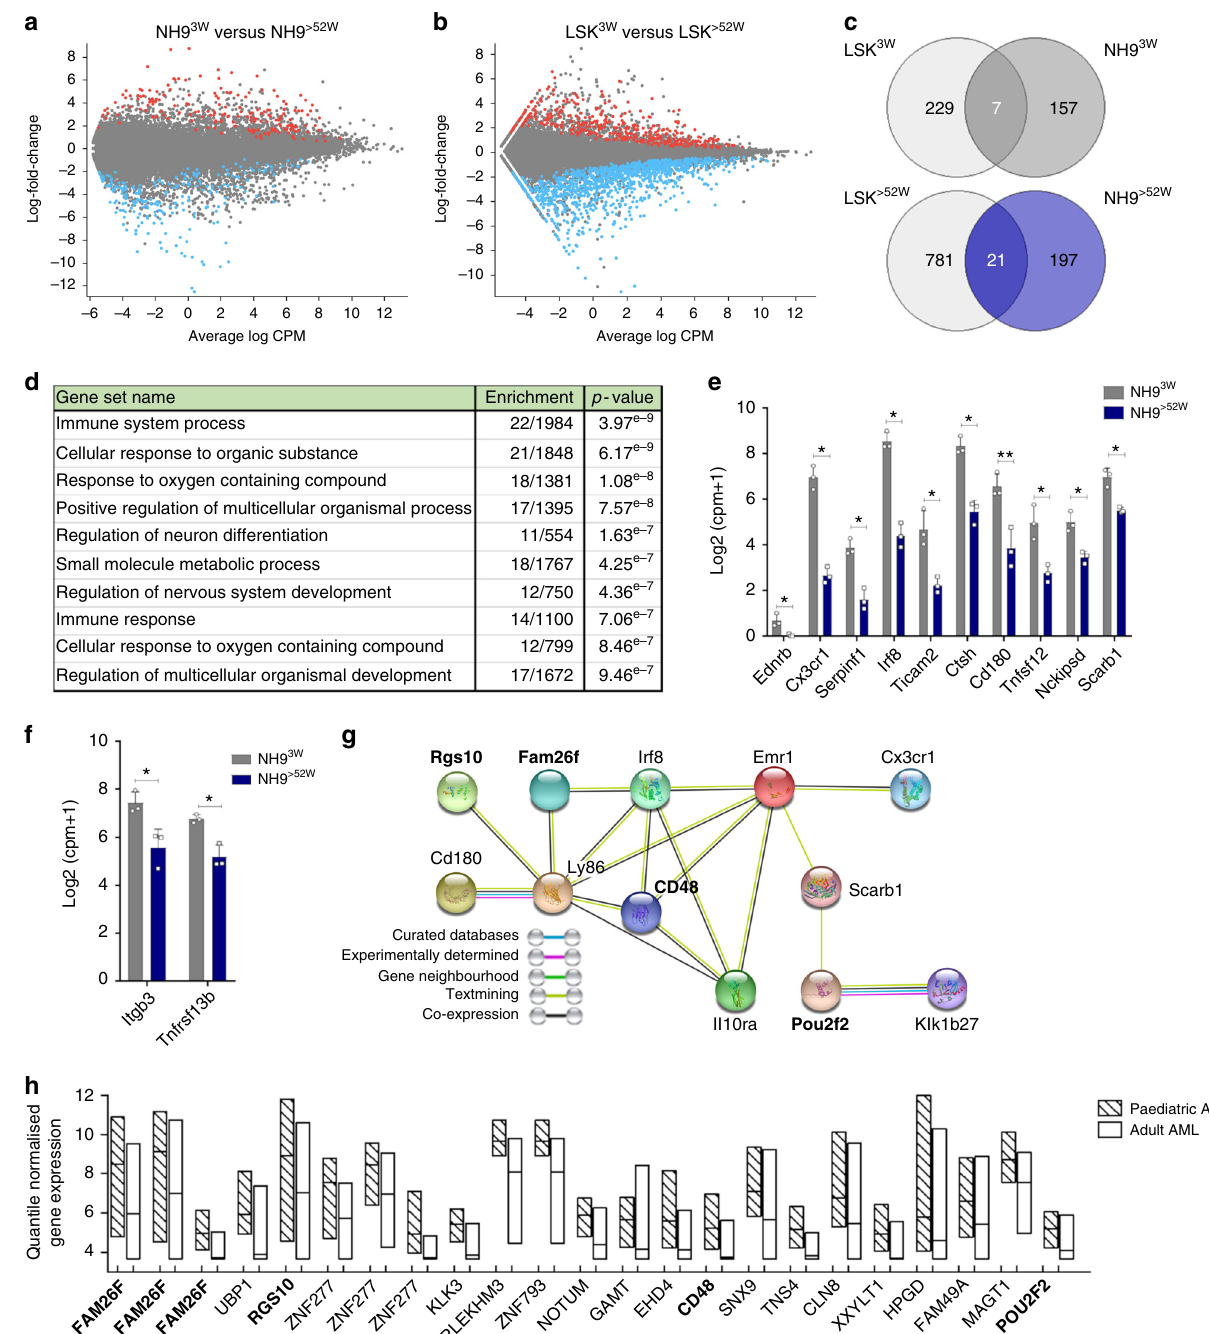
Fig. 5 Differential enrichment of pathways in age-de fi ned AML. MA plot highlighting signi fi cantly DEGs from pairwise comparisons between a myeloid leukaemia cells from NH9 3W and NH9 >52W and b healthy LSKs of 3w (LSK 3W ) and >52w (LSK >52W ) origin. 1 RNA sequencing experiment with n = 3 biological replicates per group. DEGs with adjusted p -value <0.05 and LFC ≥ 1.5 highlighted in red (up in NH9 >3W ) and in blue (up in NH9 >52W ). c Venn diagram showing overlapping genes from LSK 3W and NH9 3W DEGs (top) and LSK >52W and NH9 >52W DEGs (bottom). d Top ten enriched GO pathways using DEGs upregulated in NH9 3W compared to NH9 >52W samples but not in LSK 3W (157 DEGs). Analysis performed on MSigDB using C5 module (GO Biological Processes) with an FDR q -value of <0.05. e DEGs upregulated in NH9 3W compared to NH9 >52W but not in LSK 3W , in common to 5 or more of the top 10 pathways identi fi ed in d . f Graph of genes from cluster (ii) (See Supplementary Figure 3c, d) that are signi fi cantly upregulated in NH9 3W compared to NH9 >52W . g Protein interaction network of selected proteins whose gene expression was signi fi cantly upregulated in NH9 3W compared to NH9 >52W but not in LSK 3W , predicted by STRING. Different types of associations between the selected proteins are represented by different line colours as indicated in legend. Genes highlighted in bold were also identi fi ed as signi fi cantly enriched in the human paediatric dataset in h . h Quantile normalized gene expression of NH9 3W DEGs that were signi fi cantly enriched in human paediatric AML samples ( n = 237) compared to human adult AML samples ( n = 537). Floating bars represent min and max values with mean. Individual probes shown, some genes with multiple probes present. Genes highlighted in bold were also identi fi ed in STRING protein hub